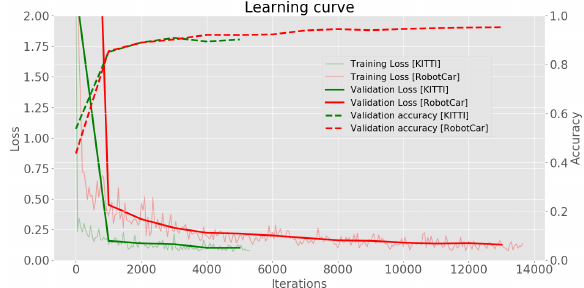
Figure 6: The learning curve for both fine-tuning steps in the baseline network.